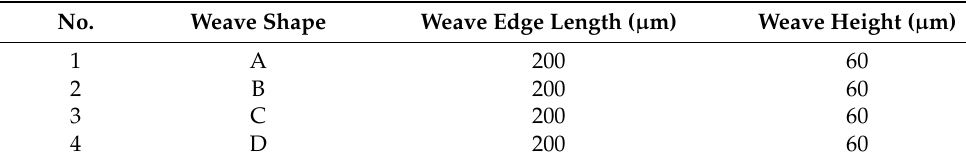
Table 6. Parameter design for experiments on the effect of weave shape. No.